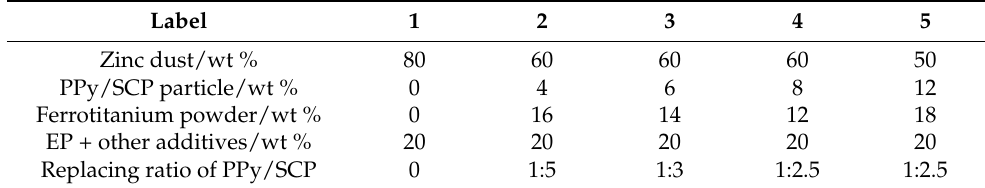
Table 1. The mass fraction of ZRP/PPy/SCP coating system through equal mass